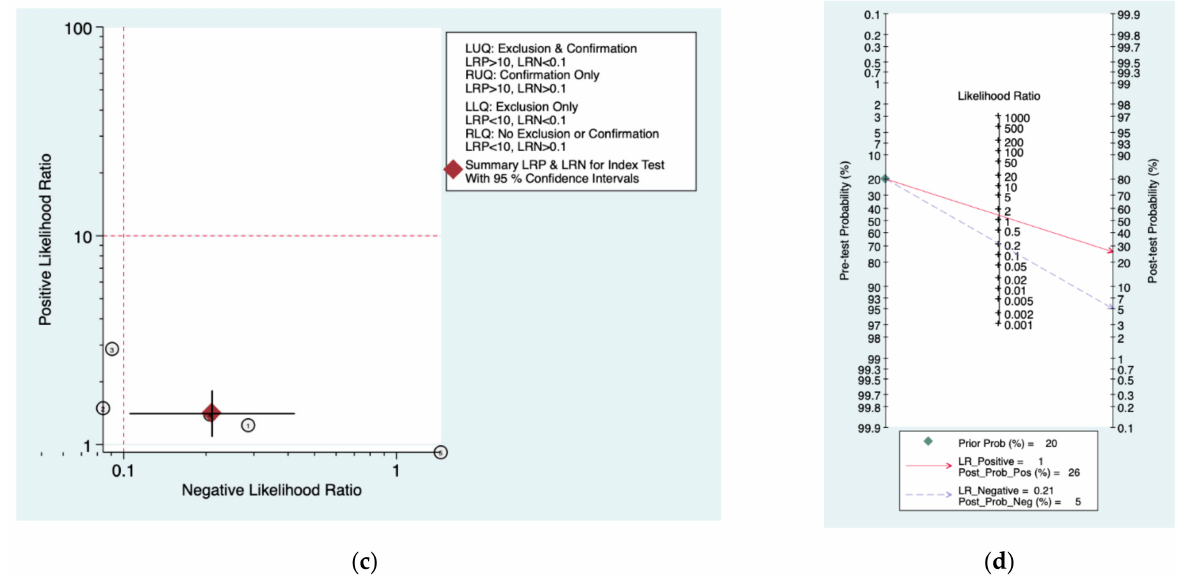
Figure 10. Meta‑analysis of Amclass protocol. ( a ) Forrest plot of pooled sensitivity and